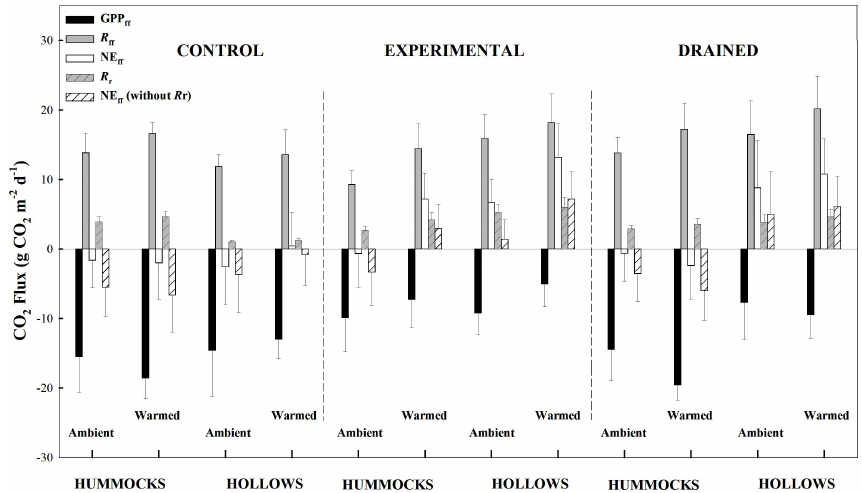
Figure 4. GPP max , R ff , NE max and R r at control, experimental and drained sites averaged over 2011–2013. NE max (without above- and below-ground parts of trees) was calculated by subtracting R r from NE max and represents net exchange of CO 2 of the ground-layer vegetation (including peat). Error bars indicate ± standard deviation. Results are from linear mixed-effect models with water table, OTC (warming) and microform and year as fixed effects and year as repeated measures. Only averaged fluxes over all study years are being graphed as the impacts of treatments were consistent in all growing